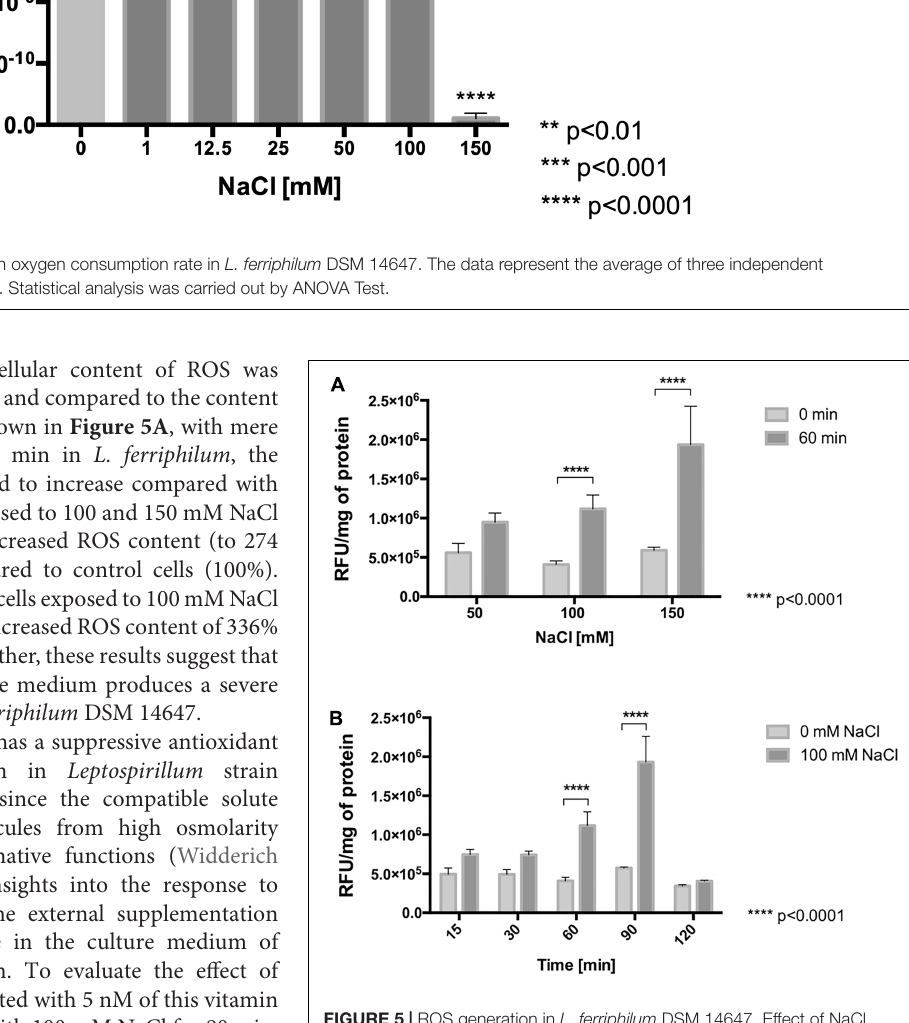
FIGURE 5 | ROS generation in L. ferriphilum DSM 14647. Effect of NaCl concentration (A) and exposure time (B) on intracellular ROS generation in the bacteria. The concentration effect was evaluated in cells exposed to NaCl for 60 min. The effect of exposure time was evaluated in cells exposed to 100 mM NaCl. Cytoplasmic ROS content was expressed as relative fluorescence units (RFU) of the activated fluorescent probe H 2 DCFDA per mg of